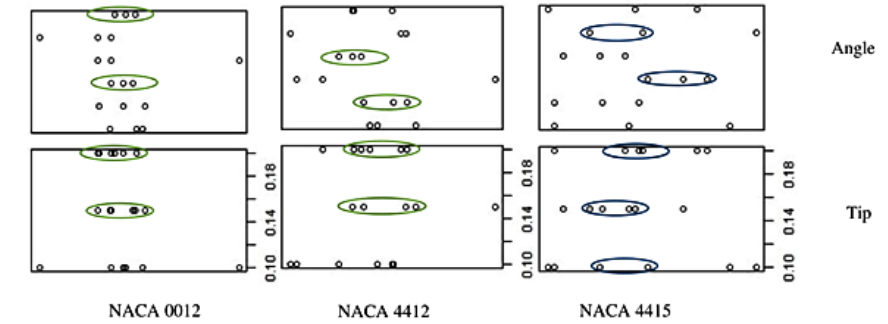
Figure 25. Three independent variables determine the axial velocity in the form of a scatter plot.